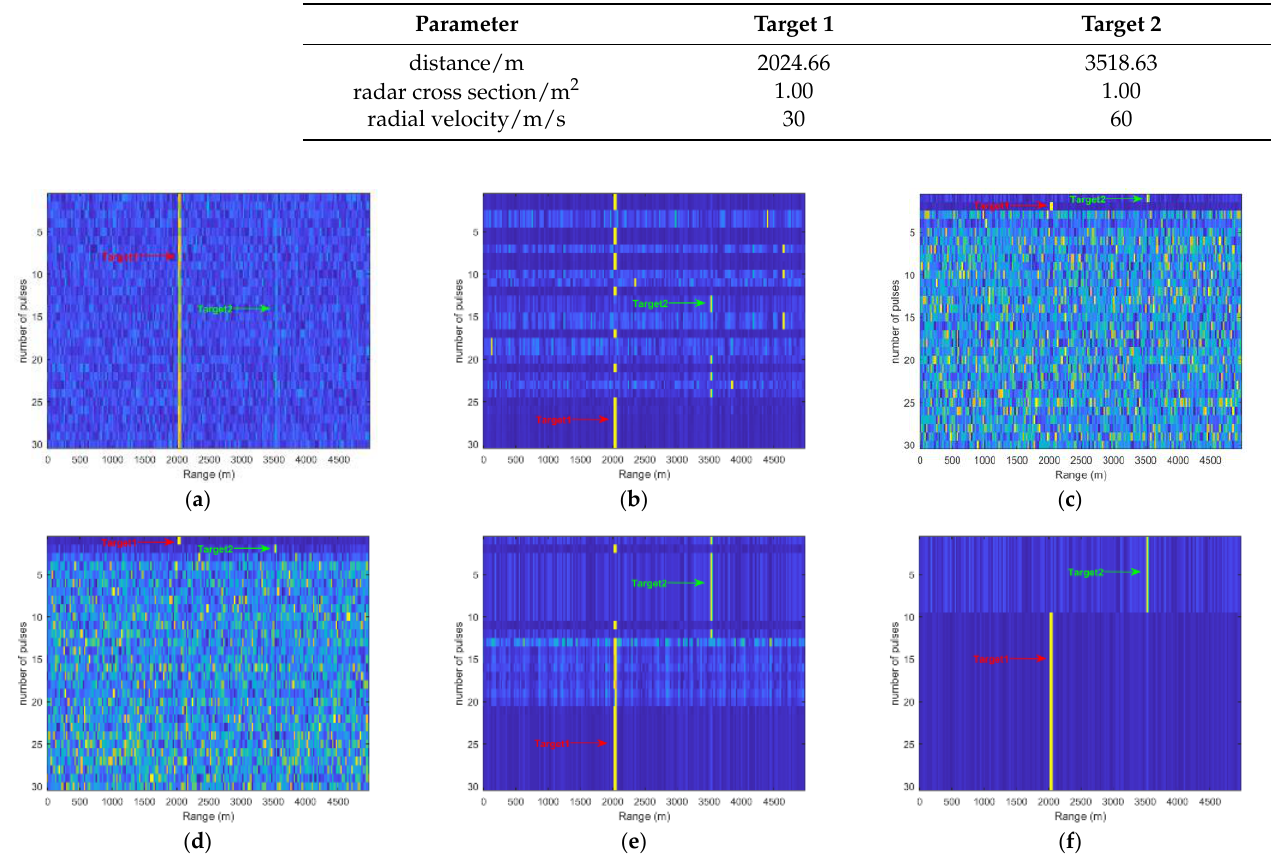
Figure 6. The results of FastICA, PSA, MPSA, NPSA and PPSA. ( a ) echo data, ( b ) the result of